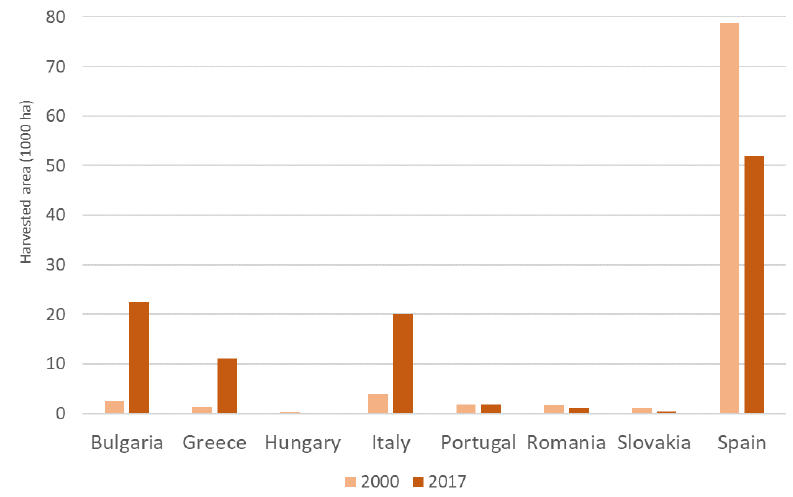
Figure 17. Harvested area of chickpea in EU countries in 2000 and in 2017 [35].